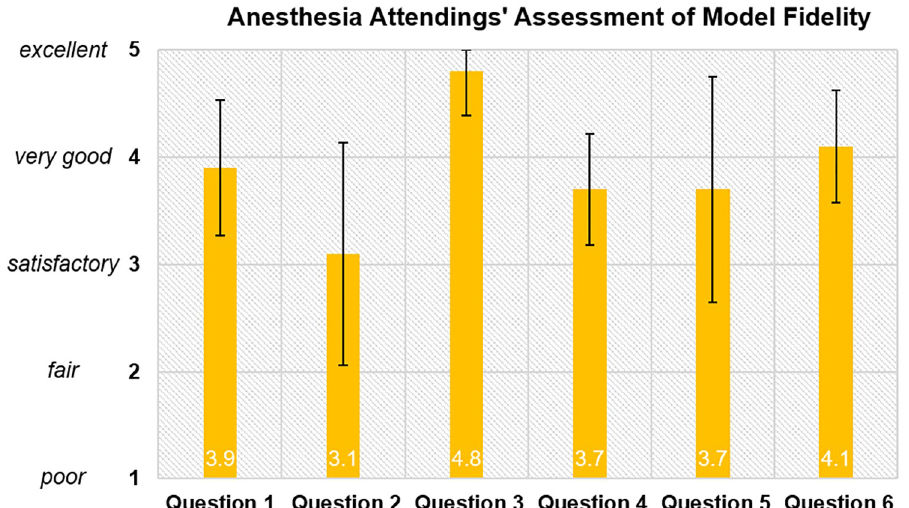
Fig 3. Anesthesia attendings’ assessment of model fidelity. Question 1. How realistic is the visual representation of the thoracic spine anatomy T7-T11? Question 2. How realistic does the soft tissue feel? Question 3. How realistic does the bone feel? Question 4. How realistic does the ligamentum flavum feel? Question 5. How realistic does the loss of resistance feel? Question 6. How useful do you think the model is as a teaching tool?